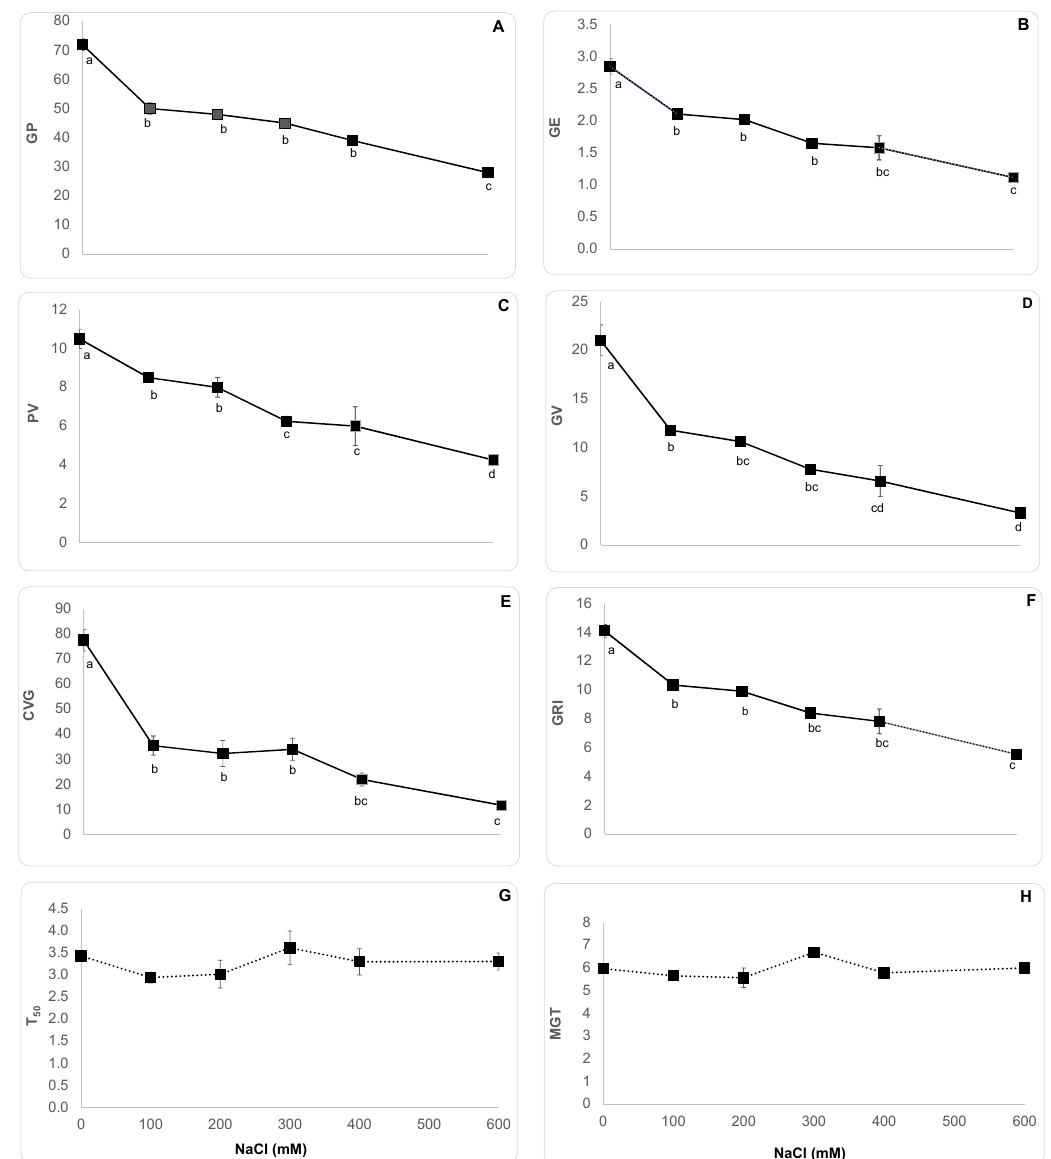
Figure 1. Effects of different salt concentrations on germination indices of Salicornia europaea seeds. GP, germination percentage ( A ), GE, germination energy ( B ), PV, peak value ( C ), GV, germination value ( D ), GRI, germination rate index ( E ), CVG, coefficient of velocity of germination ( F ), T50, time to reach 50% of germination ( G ), MGT, mean germination time ( H ). Data presented are means ± SE.